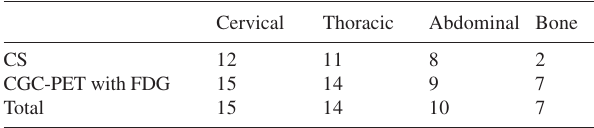
Table 3 - Number of involved sites by anatomic region Cervical Thoracic